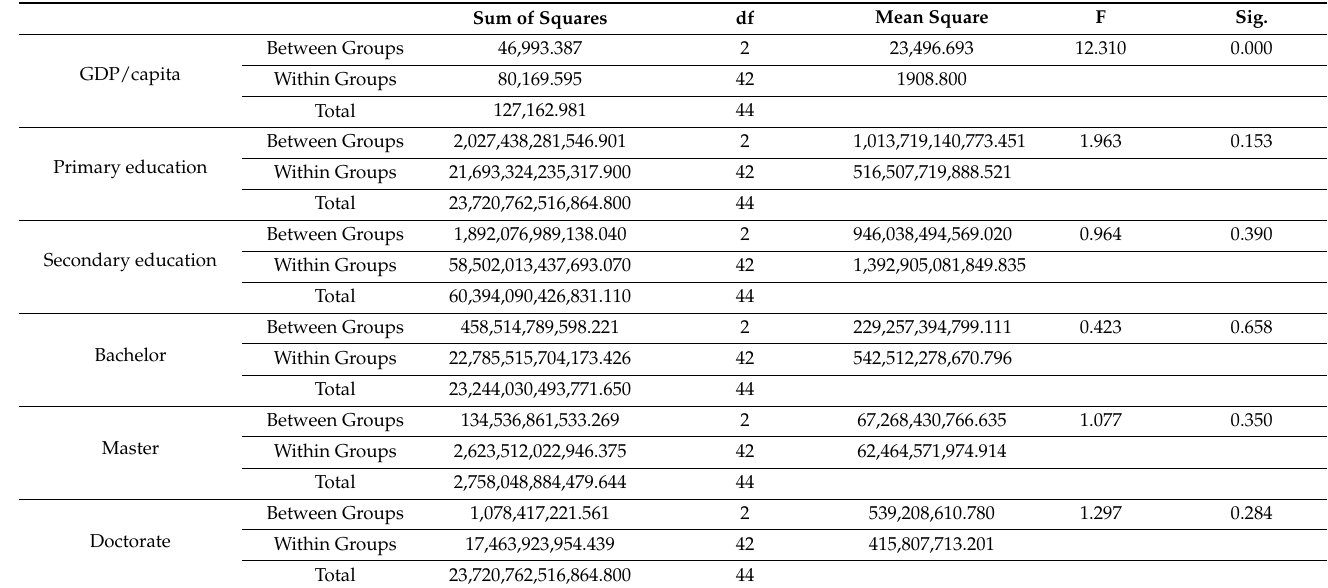
Table 4. Testing the differences between groups ANOVA. Sum of Squares